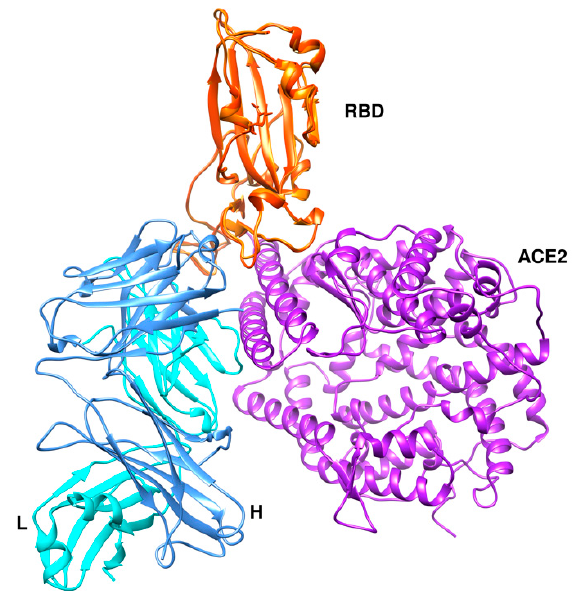
Figure 9. Crystal structure of SARS-CoV-2 P2B-2F6 antibody with RBD (PDB id 7bwj [59] superimposed onto the RBD-ACE2 complex structure (PDB id 6m0j). The RBD is shown in orange color and ACE2 in medium purple. The antibody chains are colored in cyan (L chain) and cornflower blue (H chain).